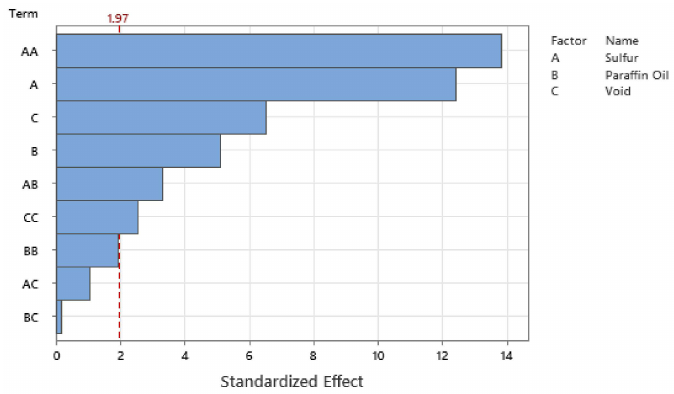
Figure 29. The Pareto Chart of Standardized Effects for n relax .